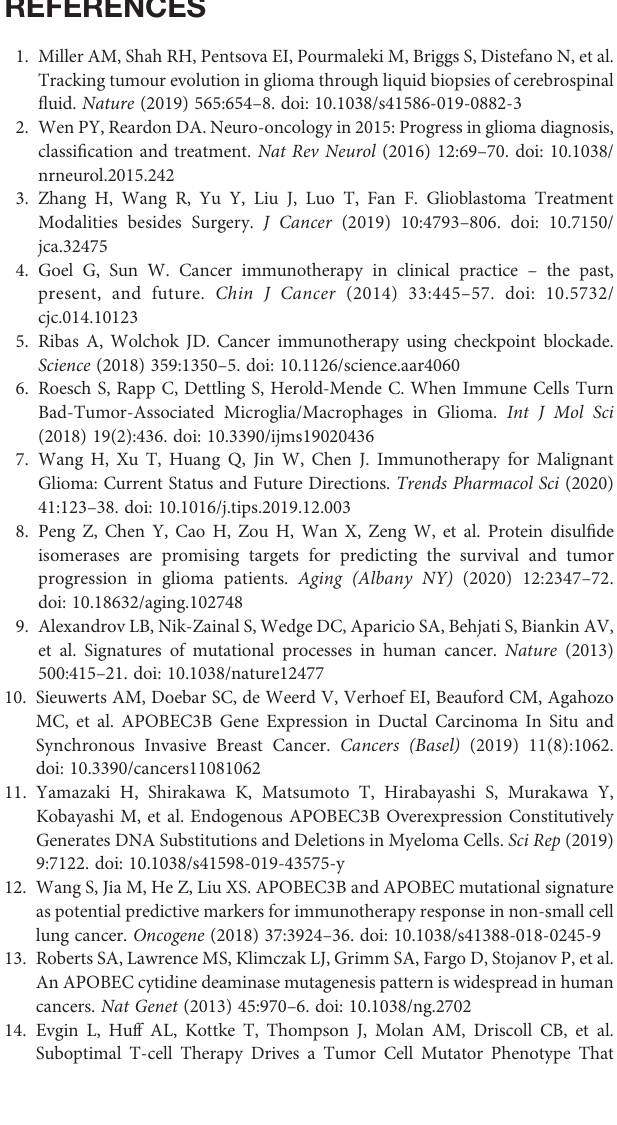
Supplementary Figure 1 | Relationship between APOBEC3B and methylation statues. (A). Relationship between APOBEC3B and the mean value of methylation status at promoter region in TCGA. Relationship between APOBEC3B and methylation status at promoter region in TCGA: (B) cg01089751, (C) cg06837067, (D) cg11816043, (E) cg14194956, (F) cg14387414, (G) cg16045423, (H) cg21707131, (I) cg25787886, (J) cg26000393. The orange dots represent IDH-mutant samples, and cyan dots represent IDH wild-type samples, respectively. The orange line and cyan line represent linear regression between APOBEC3B expression and promoter region methylation in IDH-mutant samples and IDH wild-type samples, respectively. Supplementary Figure 2 | Relationship between APOBEC3B and (A) anatomic structure analysis. CT (Cellular Tumour), HBV (Hyperplastic Blood Vessels), IT (In fi ltrating Tumour), LE (Leading Edge), MVP (Microvascular Proliferation), PAN (Pseudopalisading Cells Around Necrosis) and PNZ (Perinecrotic Zone). (B) APOBEC3B copy number in TCGA pan-glioma. (C) distinct radiographical regions of glioma. (D) different histology analysis from CGGA database. (E) different disease conditions including primary, recurrent and secondary from CGGA database. (F) different treatment outcomes.